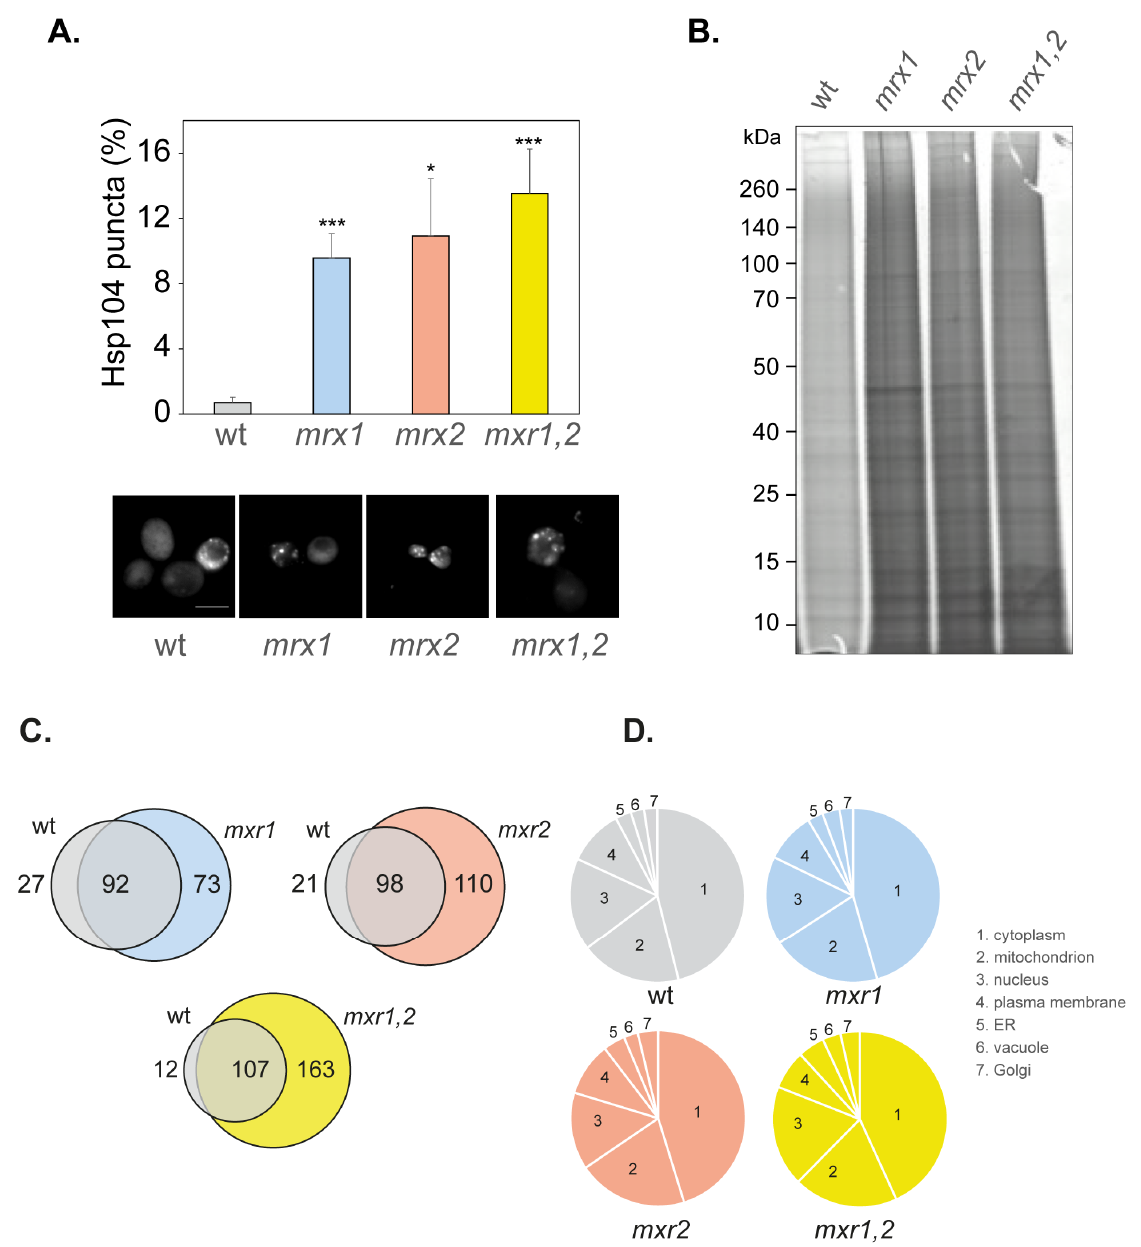
Figure 3. Strains lacking MXRs have higher levels of protein aggregation. ( A ) Hsp104-RFP was visualized in wild-type and MXR mutant cells grown to the exponential phase. Examples of cells containing visible puncta are shown. The percentage of cells containing visible Hsp104-RFP puncta was quantified for each strain. Data shown are the means of three independent biological repeat experiments ± SD. Significance is shown compared with the wild-type strain; * p < 0.05, *** p < 0.001. ( B ) Protein aggregates were isolated from the same strains and analyzed by SDS-PAGE and silver staining. ( C ) Proteins within insoluble aggregate fractions were identified by mass spectrometry. The Venn diagrams show pairwise comparisons of the overlaps between the proteins aggregating in wild-type and MXR mutant strains ( mxr1 , mxr2, mxr1,2 ). ( D ) Venn diagrams showing the localization of the proteins that aggregate in the wild-type and MXR mutants.